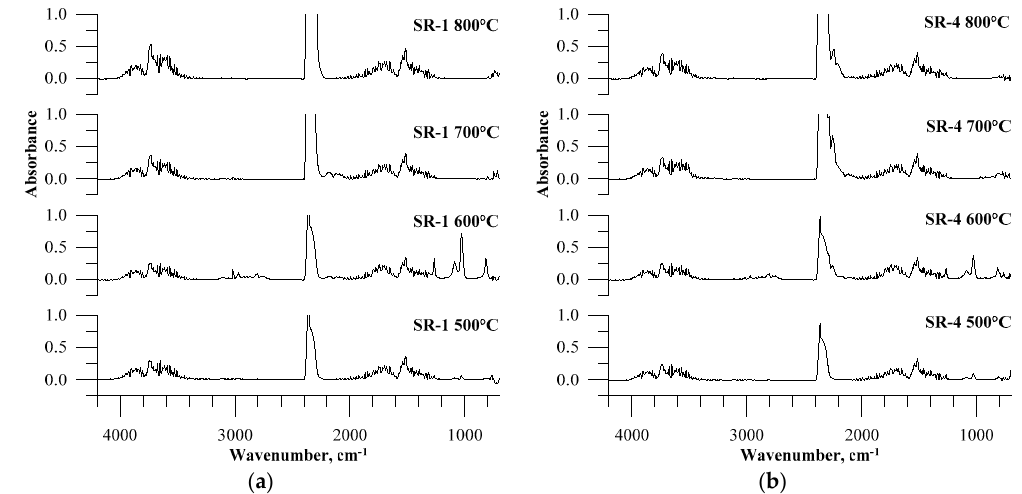
Figure 2. Fourier transform (FTIR) spectra of gaseous products of silicone rubber composites thermal decomposition: ( a ) SR-1; ( b ) SR-4 at examined